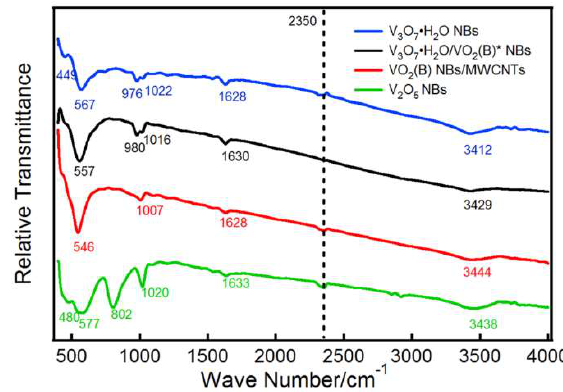
Figure 5. FTIR spectra of V 3 O 7 ·H 2 O NBs, V 3 O 7 ·H 2 O/VO 2 (B)* NBs, VO 2 (B) NBs/MWCNTs and V 2 O 5 NBs between 400–4000 cm − 1 .